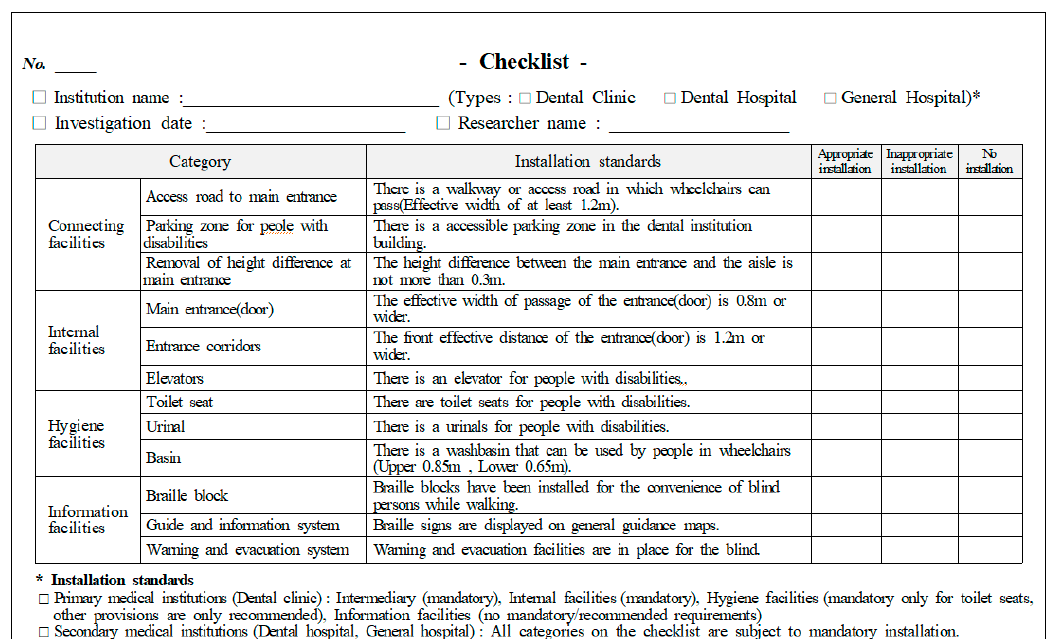
Figure 1. Checklist for installation of convenience facilities.